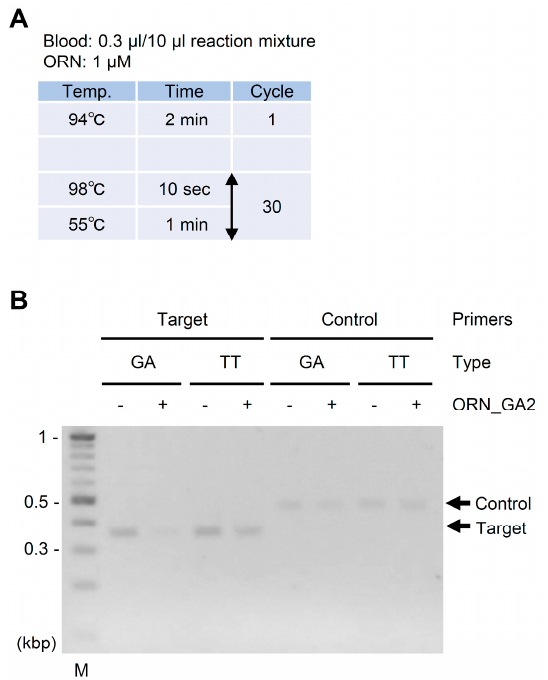
Figure 4. Discrimination of the Gstm1 polymorphism in whole blood specimens by ORNi-PCR. ( A ) Experimental conditions for ORNi-PCR. ( B ) Results of ORNi-PCR. Rat whole blood was directly used as a template without DNA extraction. M—molecular weight marker. Positions of primers and ORN_GA2 are shown in Figure 2A.